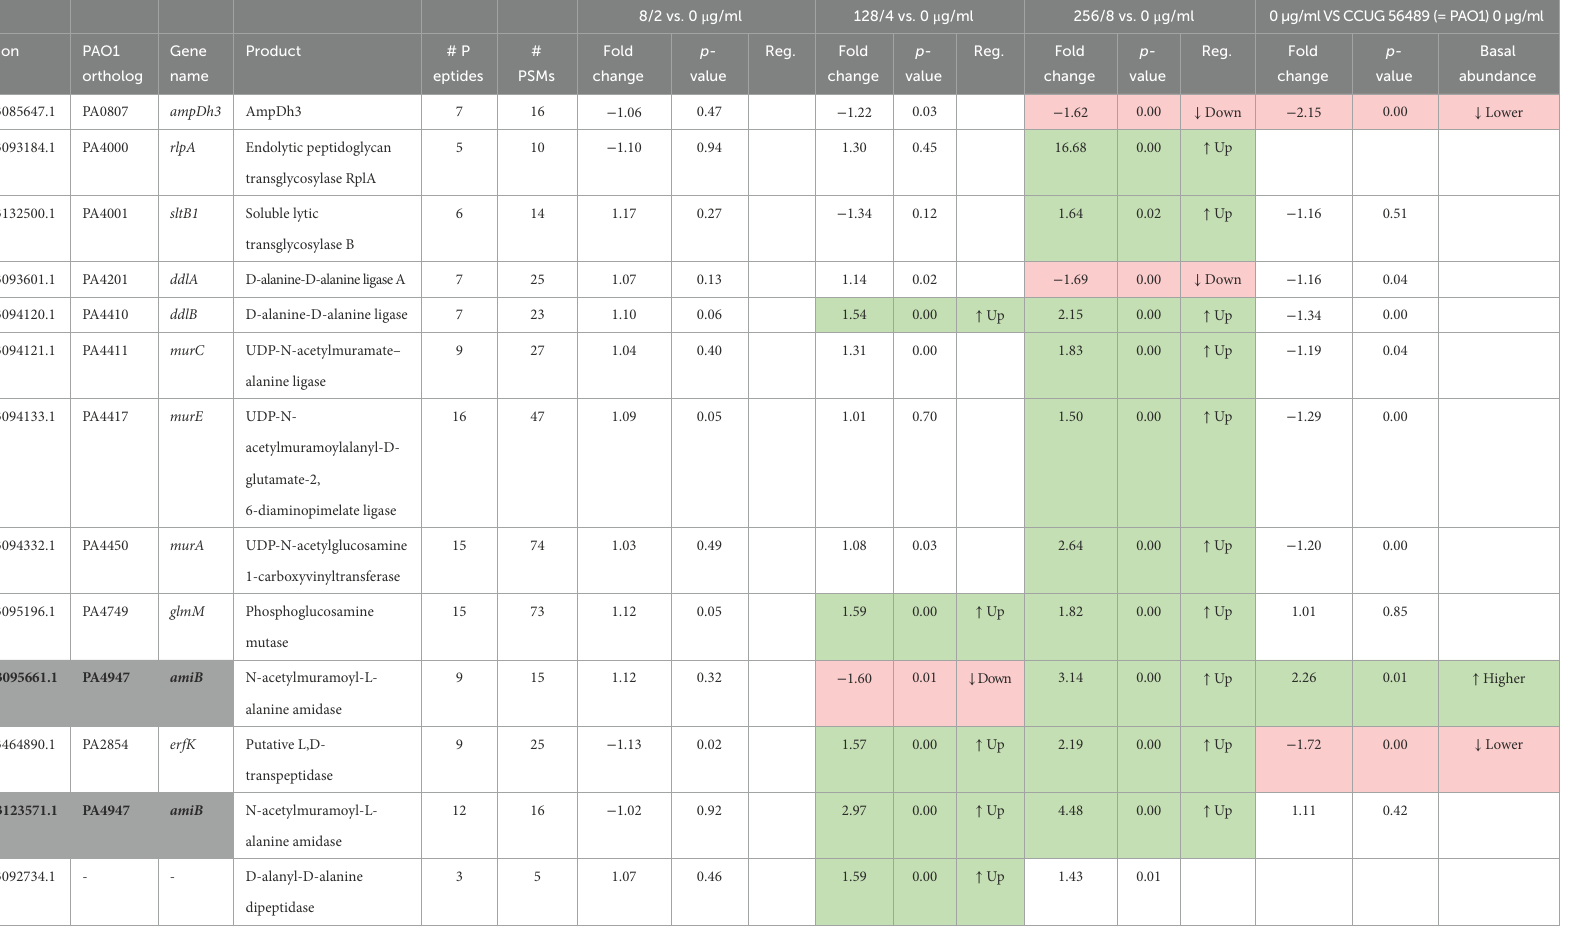
TABLE 7 Additional differentially regulated proteins related with peptidoglycan metabolism and cell wall